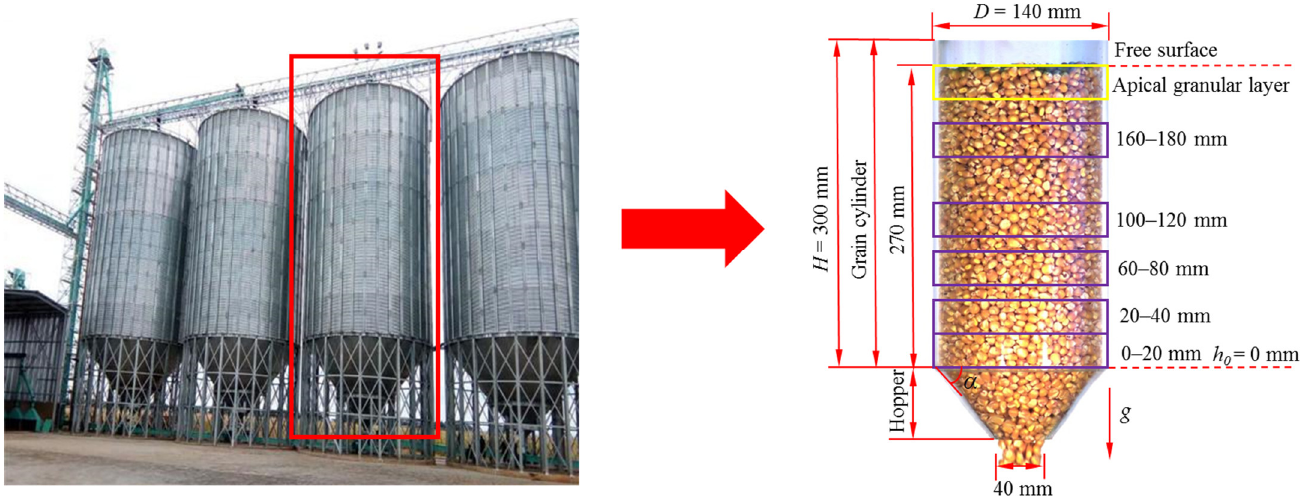
Figure 2. Structure diagram of vertical grain cylinder.